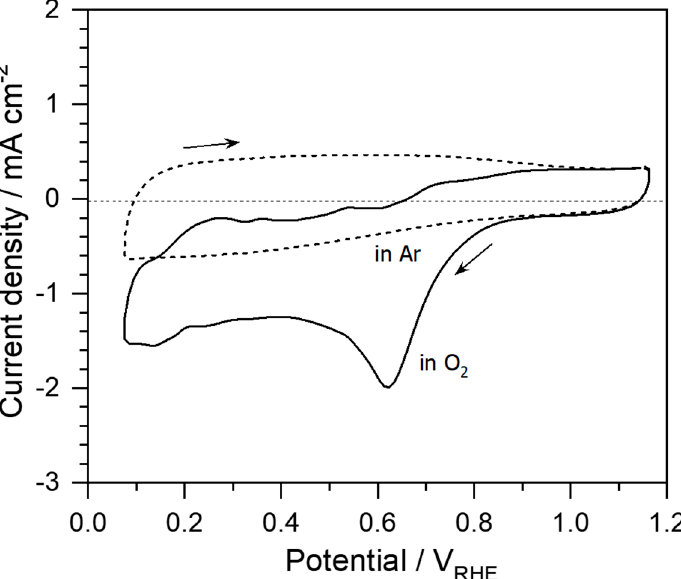
Figure 3. CVs of the ultrafine TaO x /CB nanoparticles prepared by electrodeposition and subsequent annealing treatment in an H 2 flow. The electrochemical measurements were carried out in Ar- and O 2 -saturated 0.1 M KOH aqueous solutions at a scan rate of 100 mV s − 1 .